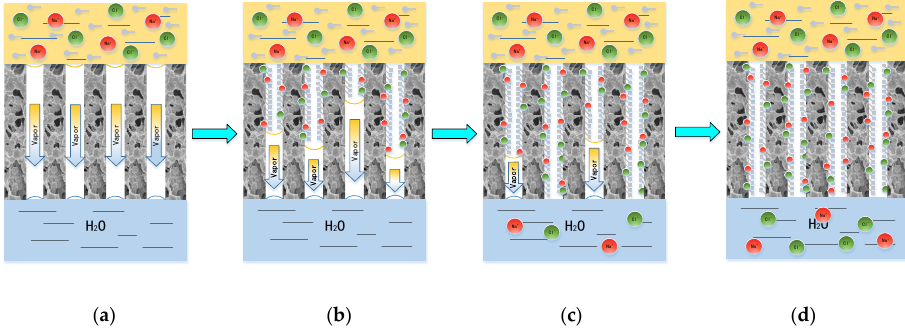
Figure 10. Surfactant wetting mechanism of the membrane: ( a ) Not wetted, ( b ) Surface wetted, ( c ) Partially wetted, ( d ) Completely wetted.